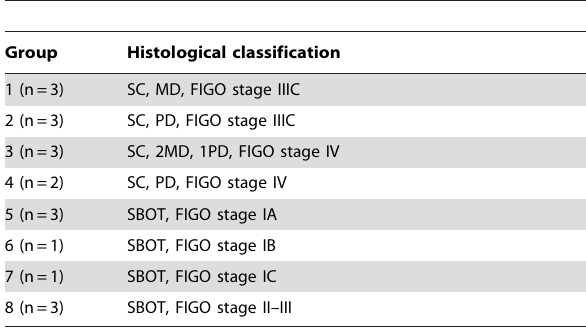
Table 1. Histological classification and group selection for patients selected for global gene expression analyses.